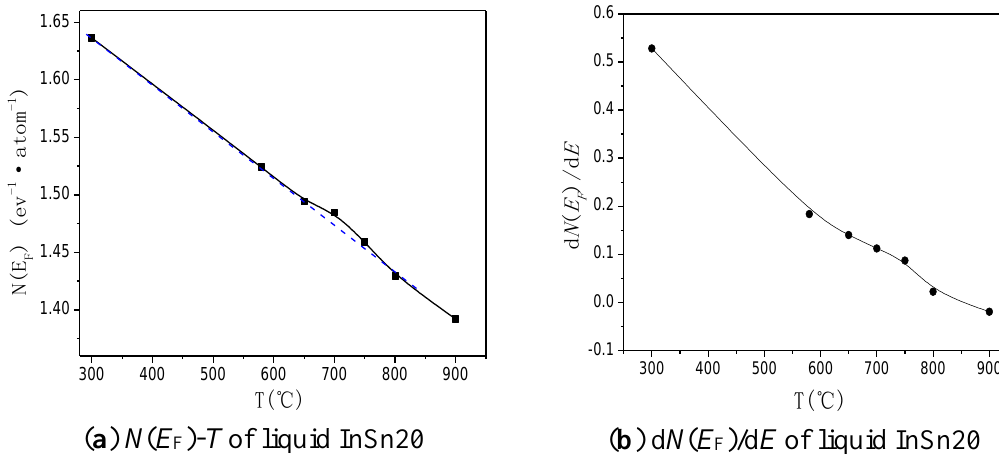
Figure 16. The density of state N ( E F ) and The d N ( E F )/d E of liquid InSn20 versus temperature